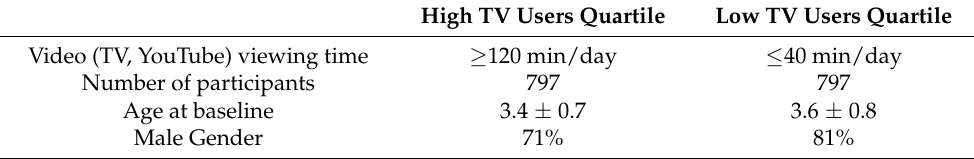
Table 2. High- and low-video-watching-duration quartiles demographics